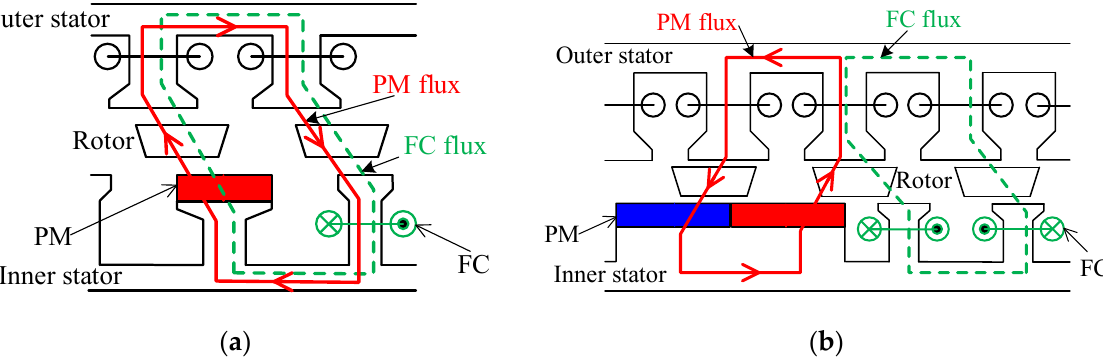
Figure 13. Illustrations of PM and FC flux paths of series and parallel HE machines. ( a ) Series HE.